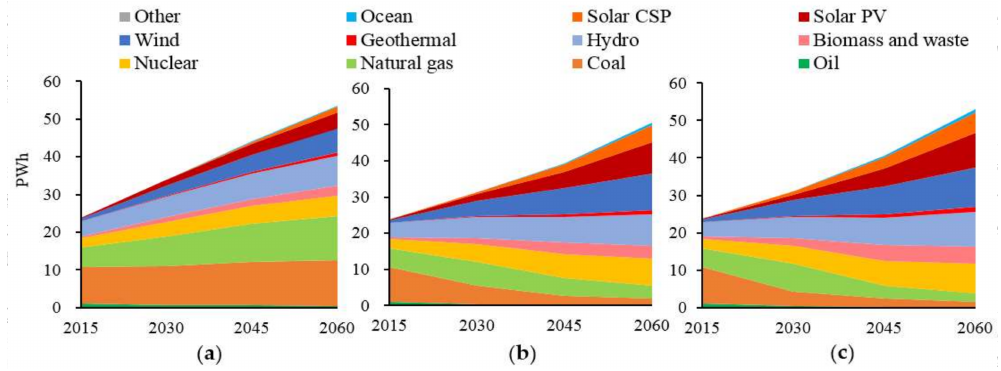
Figure 3. Global electricity generation in each scenario (after IEA [4]). ( a ) RTS ( b ) 2DS ( c )